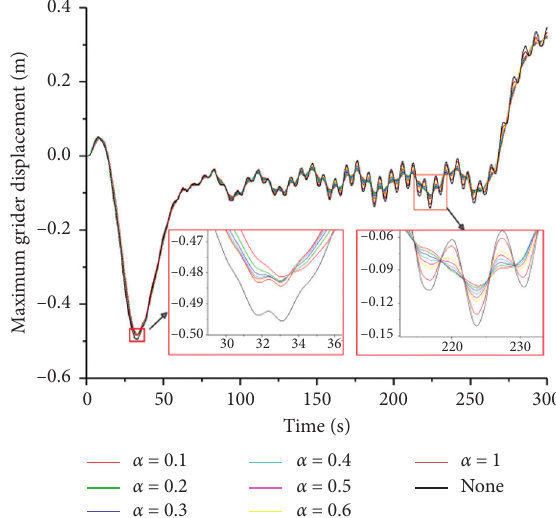
Figure 27: Time history curve of maximum girder displacement ( C � 5000kN/ ( m/s ) α ).